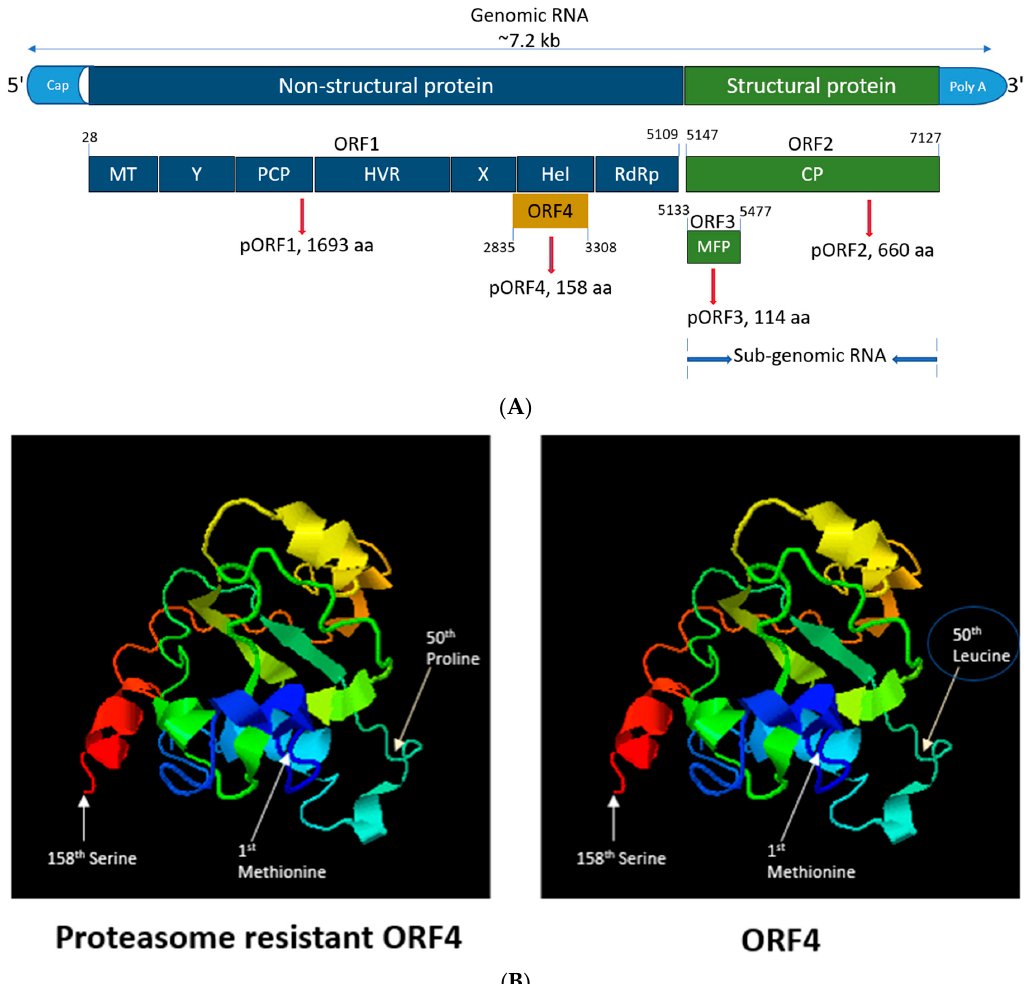
Figure 1. Genomic organization, functions of HEV ORFs and crystal structure of ORF4 protein. ( A ) The (+)-sense HEV genome is capped at the 5 ′ end, polyadenylated at the 3 ′ end and can be translated directly by host ribosomes [32]. ORF1 consists of various domains such as methyl transferase (MT), the X domain, papain-like cysteine protease (PCP), hypervariable region (HVR), the Y domain, helicase (Hel), RNA-dependent RNA polymerase (RdRp). Nucleotides 1–979 of HEV ORF1 encode the region responsible for capping the genome that gets translated to a protein of 110 kDa that possesses methyl transferase and guanylyltransferase activity. The protein allows for the transfer of the methyl group to guanosine triphosphate, giving m7-GTP, which gets covalently coupled to the 5 ′ end of the HEV genome [33]. The X domain binds poly-ADP ribose which is thought to play role in viral replication and/or translation. PCP is known for processing the HEV polyprotein into discrete function units. The Y domain possesses sequence conservation of several motifs within this region across all known HEV genotypes. HVR is rich in proline and plays a structural role as a flexible hinge between adjoining ORF1 regions [34]. Hel domain possesses NTPase activity and is capable of hydrolyzing ATP. RdRp synthesizes sense and antisense RNA transcripts using antisense and sense viral RNA templates, respectively [35]. A bicistronic subgenomic mRNA encodes both the ORF2 and ORF3 proteins of hepatitis E virus [36]. ORF2 encodes for the viral capsid protein (ORF2 C ) and the free form of the antigen (ORF2 S) , and ORF3 encodes for multi-functional proteins, small phosphoproteins that is involved in viral morphogenesis, host signaling modification and egress [37,38]. ORF1 begins from 28 nucleotides and terminates at nucleotide position 5109. ORF1 translates into a non-structural protein (pORF1) with 1693 amino acids (aa). ORF2 starts at nucleotide 5147 till nucleotide position 7127. ORF2 translates into a structural protein (pORF2) with 660 aa. ORF3 starts at nucleotide 5133 and terminates at nucleotide 5477. ORF3 translates into structural protein (pORF3) with 114 aa. ORF4 starts at nucleotide 2835 and terminates at nucleotide 3308. ORF4 translates into pORF4 with 158 aa [19]. ( B ) Predicted 3D structure of the ORF4 protein using I-TASSER server [39,40] depicting the start (Methionine), end (Serine) and 50th aa mutation (from leucine to proline) leading to proteasome-resistant ORF4.